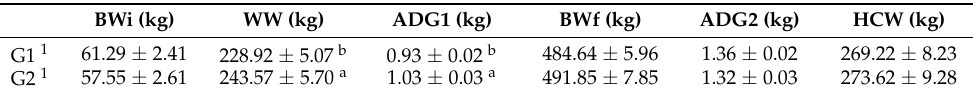
Table 1. Means and respective standard errors of body weight at the beginning of the cow-calf phase, body weight at weaning, body weight at the end of the feedlot period, pre- and post-weaning average daily gain, and hot carcass yield obtained for the two treatments.